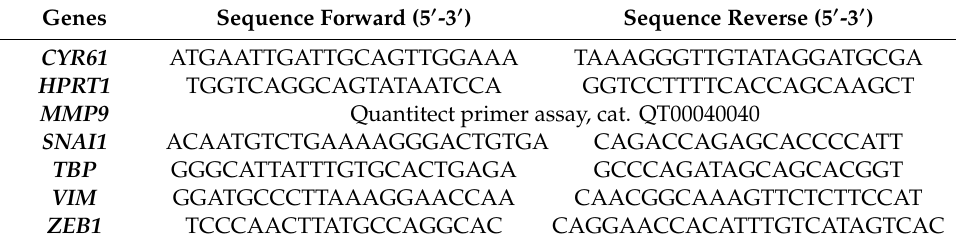
Table 1. RT-qPCR primers sequences used in this